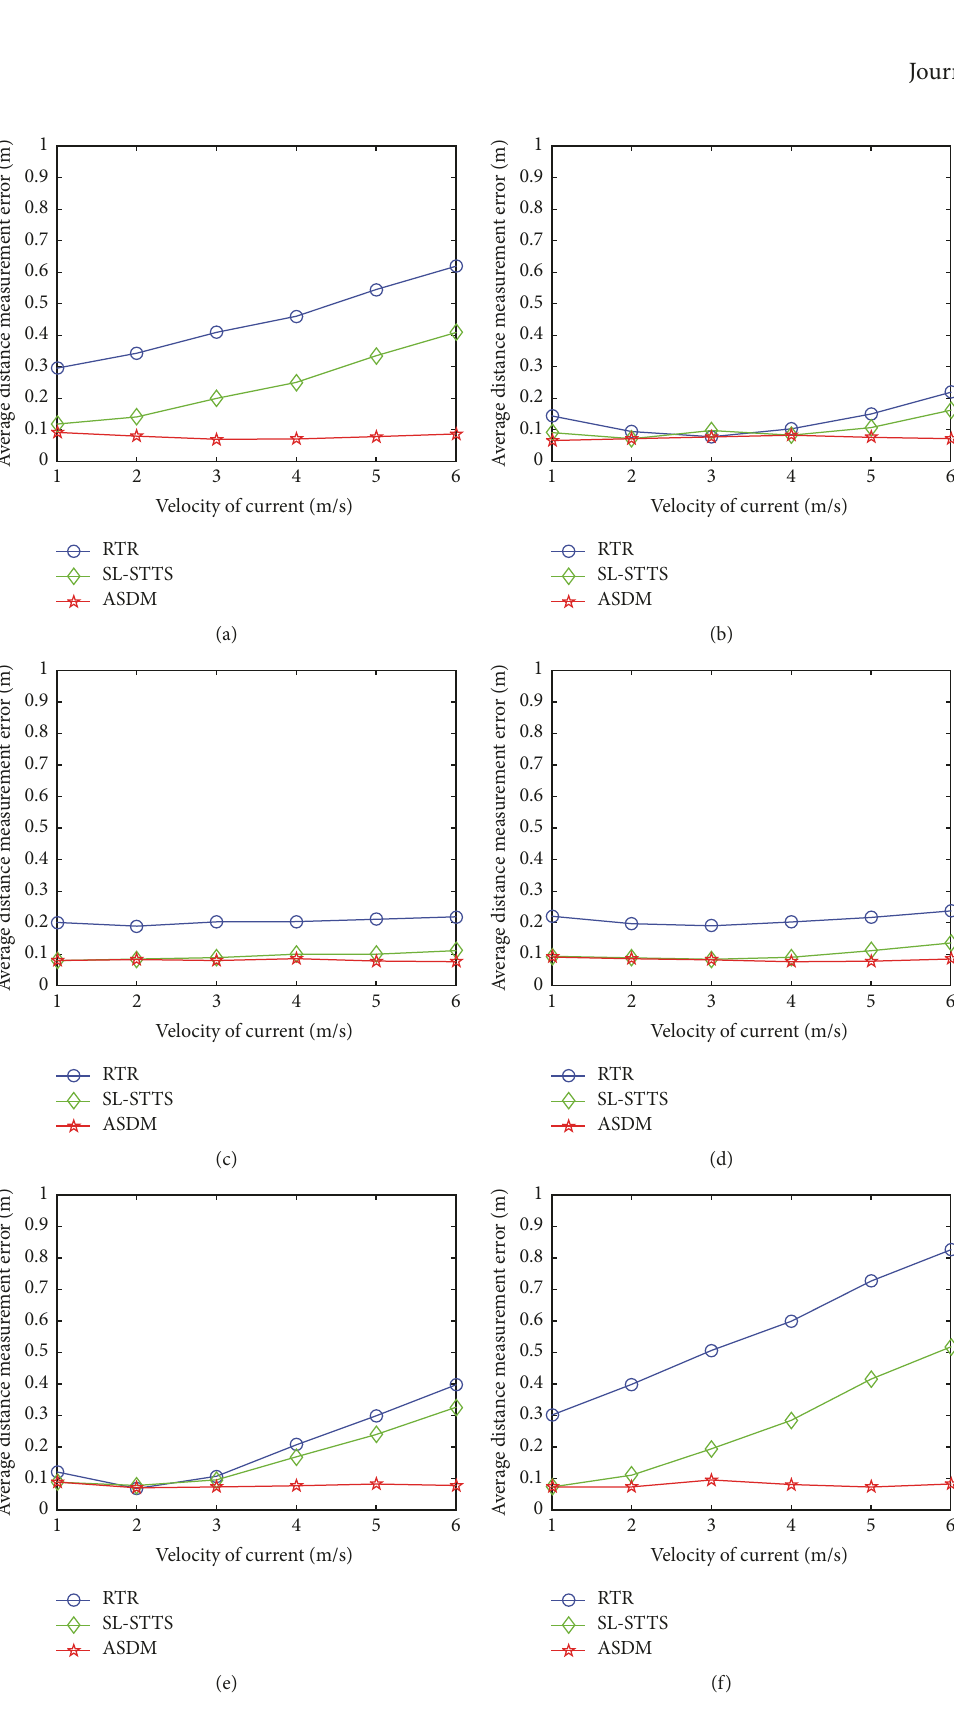
𝑒 𝑐 𝜋/2 ; the differences are that 𝑒 𝑐 𝑟 and 𝑓 is